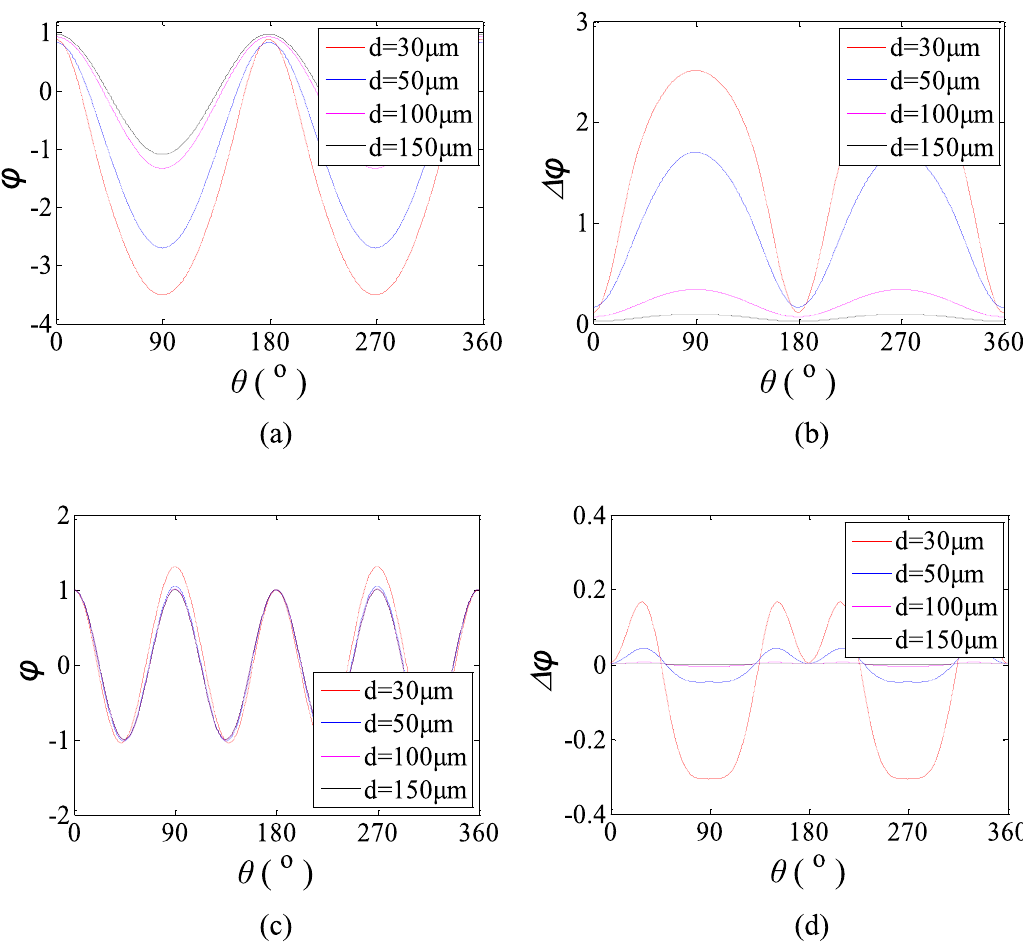
Fig. 6. Vibration modes for different thickness d. (a) Mode 1 (b) D f = f e (cid:1) f 3 for mode 1 (c) mode 2 (d) D f = f e (cid:1) f 3 for mode